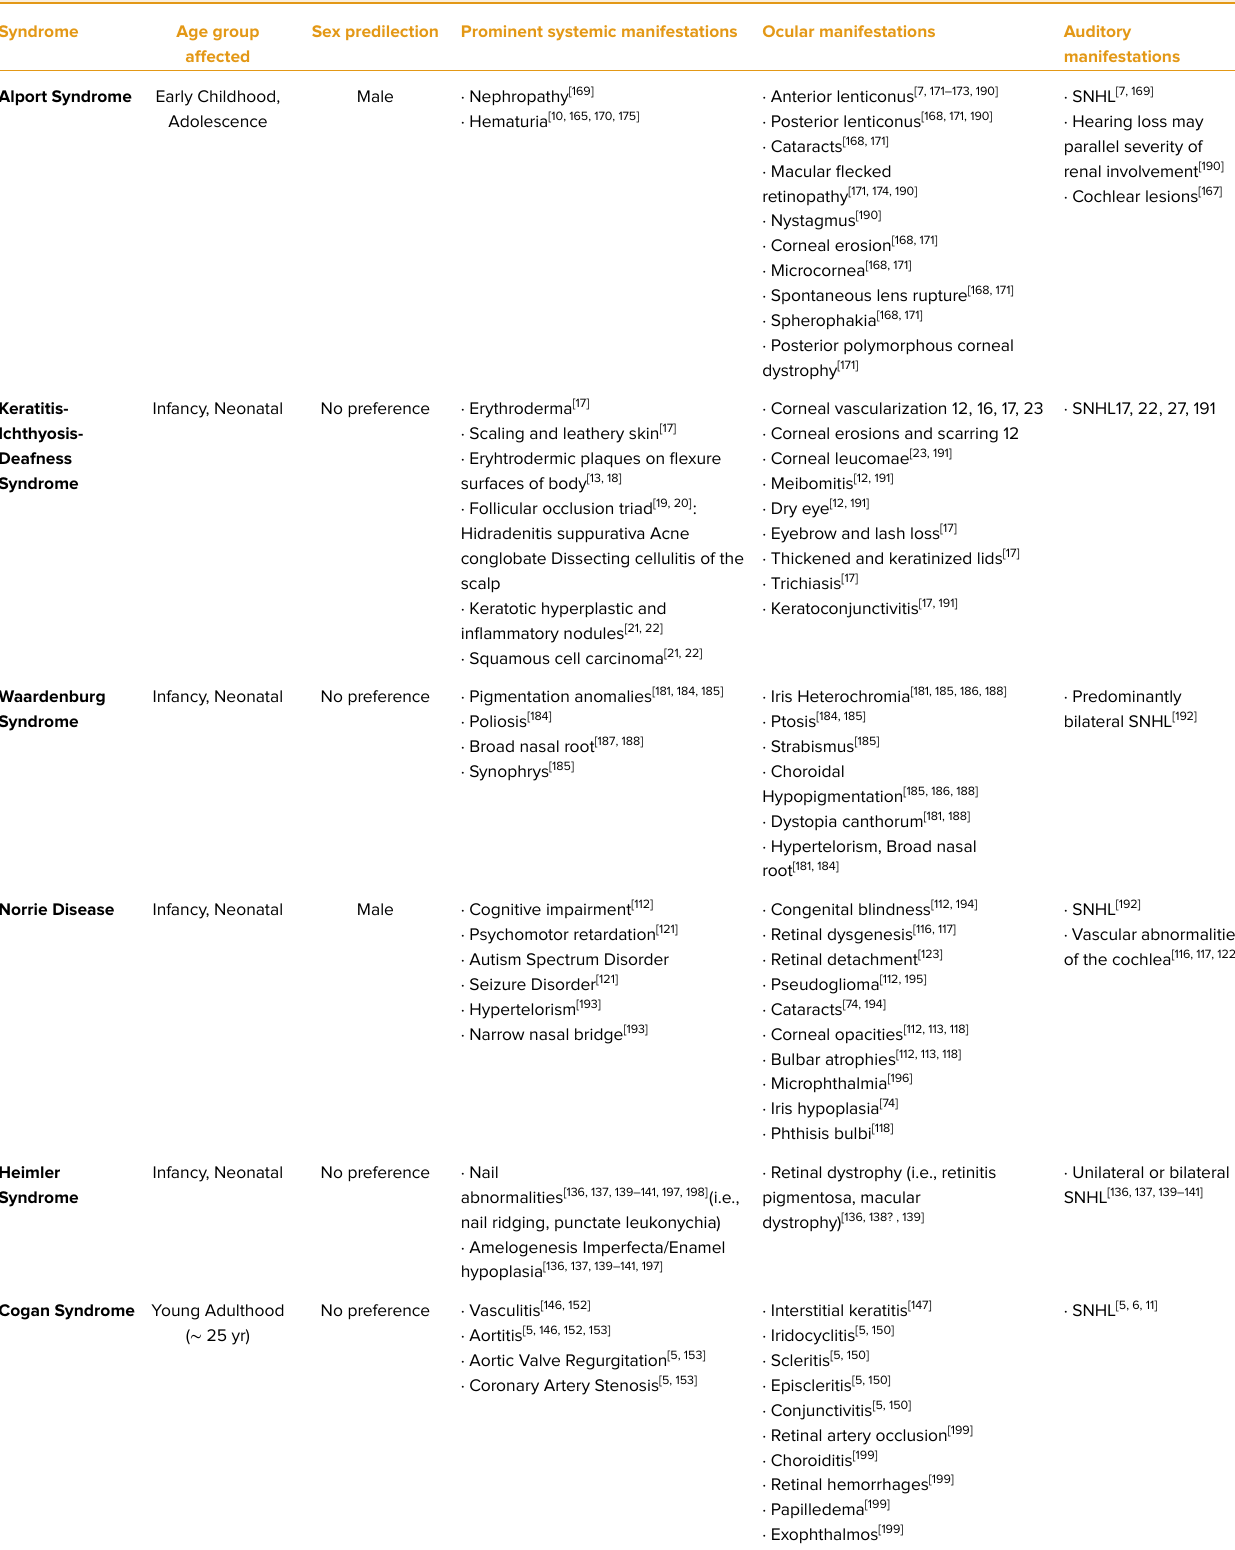
Table 1. Summary of syndromes that include both ocular and sensorineural hearing loss